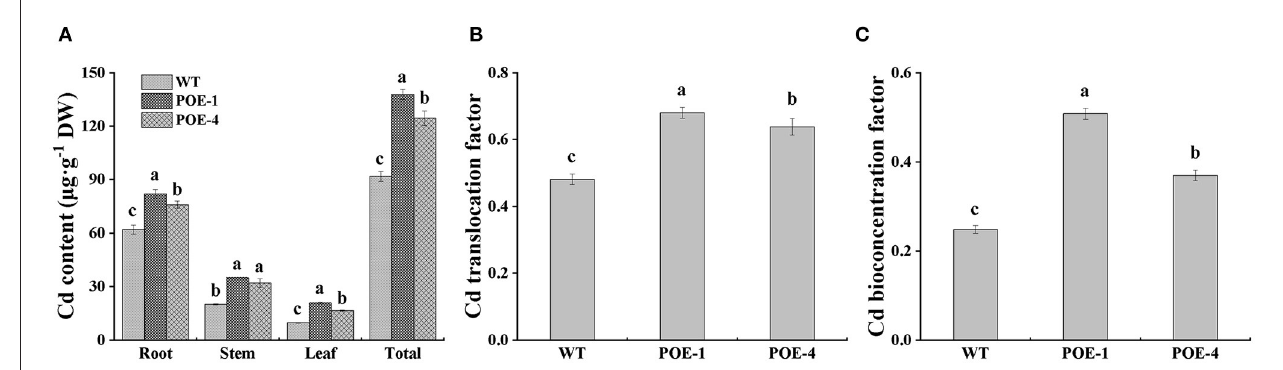
FIGURE 6 | PscCYP716A1 promotes Cd accumulation and translocation. (A) Cd accumulation in different organs. (B,C) Translocation factor (TF) and bioconcentration factor (BCF) of Cd. All of the data are shown as the mean ± SD of three biological duplicates. Different letters represent statistical discrepancies ( p < 0.05) between transgenic lines and